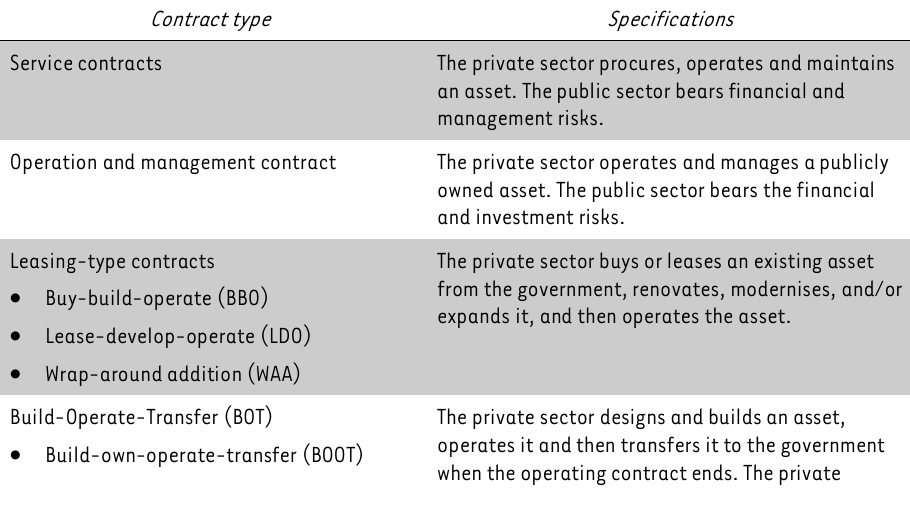
Public-private partnership models Contract